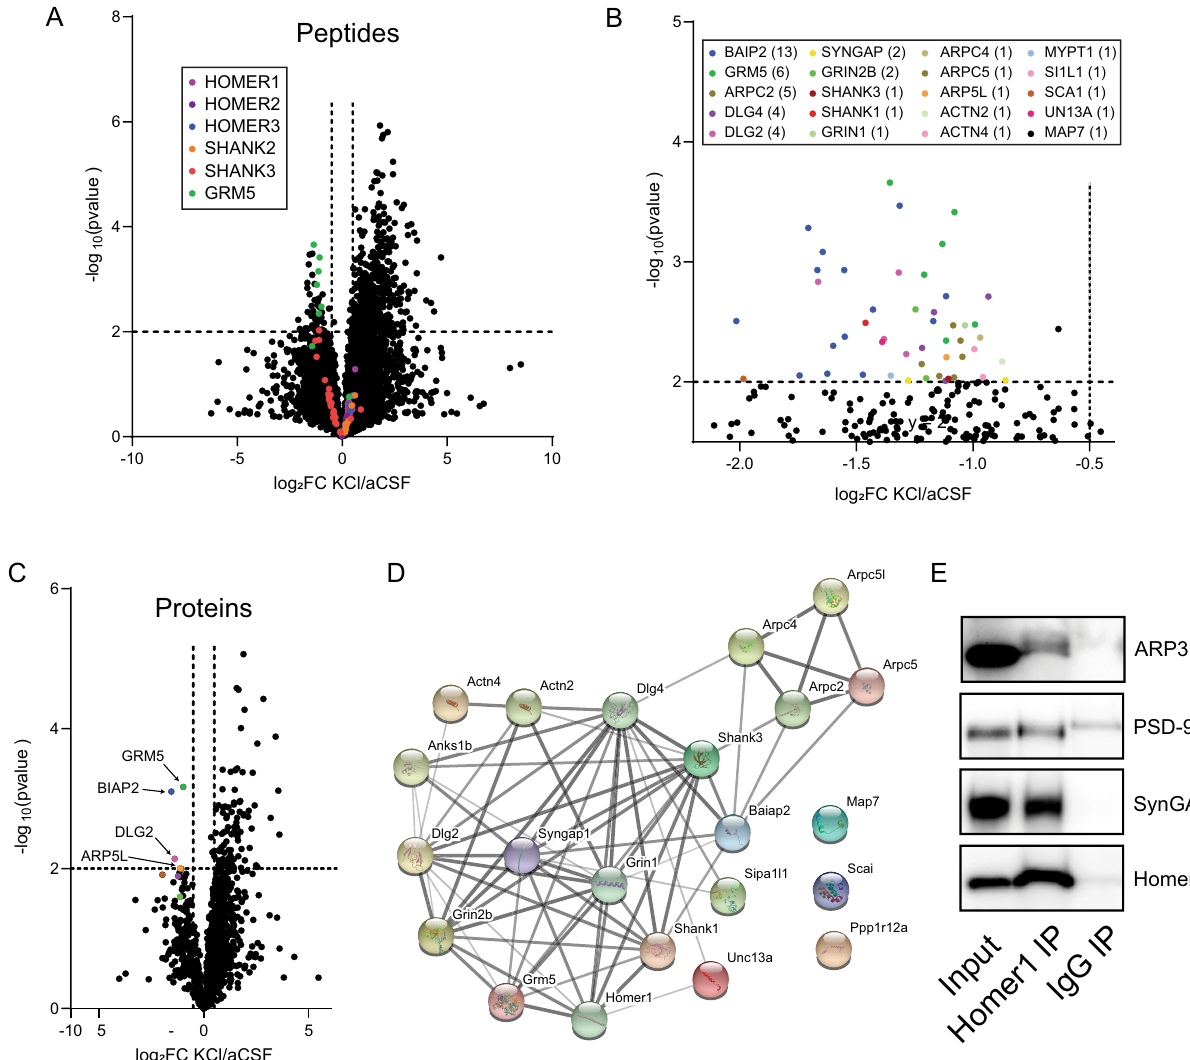
Figure 4. Co-IP’d peptides and proteins identified comparing aCSF vs. KCl in WT lysates. ( A ) Volcano plot showing peptides that were enriched and depleted in aCSF vs. KCl. Peptides that were identified as enriched in WT vs KO in the aCSF condition are color-coded as shown in the key. ( B ) The same volcano lot from ( A ) is shown with the scale changed to highlight significantly depleted peptides, and all peptides that meet significance criteria color-coded by protein identity. Key shows color-coding of peptides by protein identify. ( C ) Volcano plot showing proteins that were depleted in aCSF vs. KCl. Depleted proteins are labeled. ( D ) StringDB node-edge diagram of the identified peptides from ( B ), highlighting the known interactions. ( E ) IP-western blots confirm that ARP3, PSD95 (DLG4) and SynGAP co-associate with Homer1, but not with nonspecific IgG